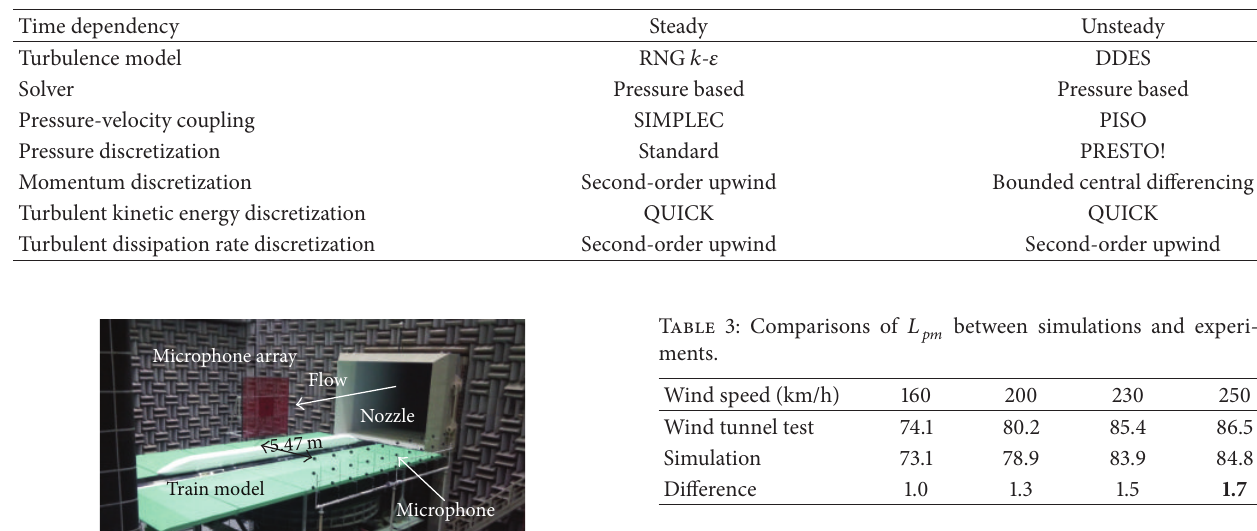
Figure 3: Distribution of the spatial grids. Table 2: Main modelling schemes adopted for the CFD simulations.